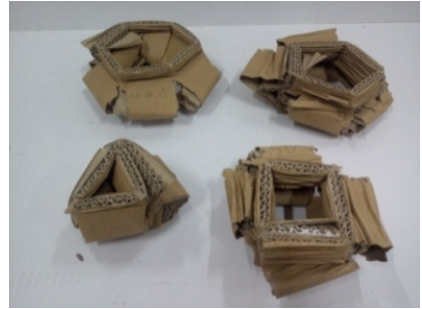
Figure 5: Deformation modes of paper corrugation tubes along Y